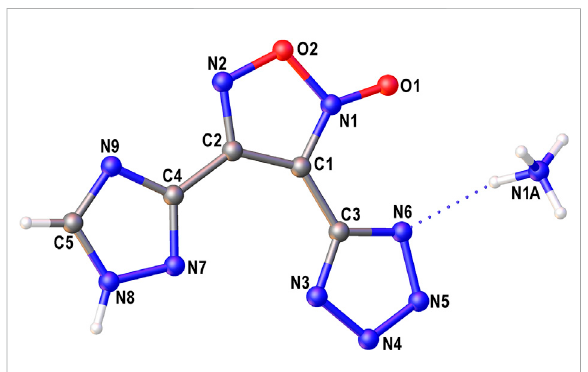
FIGURE 3 The general view of symmetry independent part of compound 6 . Non-hydrogen atoms are drawn by probability ellipsoids of atomic displacements ( p = 0.5).